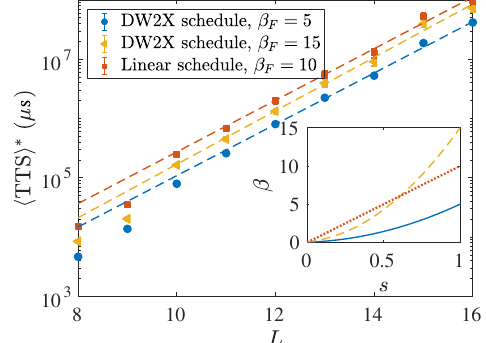
FIG. 12. Median scaling for SA on the logical-planted instances with three different annealing schedules. We compare the median TTS for SA using three different annealing schedules, 0 . 132 B ð s Þ , where B ð s Þ is from the DW2X annealing schedule in Fig. 9(b), 0 . 396 B ð s Þ , and a linear schedule. The dashed lines correspond to the exponential fits exp ð a þ bL Þ with a ¼ 12 . 457 (cid:5) 0 . 332 , b ¼ 0 . 996 (cid:5) 0 . 24 and a ¼ 12 . 489 (cid:5) 0 . 888 , b ¼ 1 . 037 (cid:5) 0 . 064 for the DW2X schedules and a ¼ 13 . 321 (cid:5) 0 . 934 , b ¼ 1 . 002 (cid:5) 0 . 066 for the linear schedule. Inset: The annealing schedules in the inverse temperature β as a function of the dimensionless parameter s .